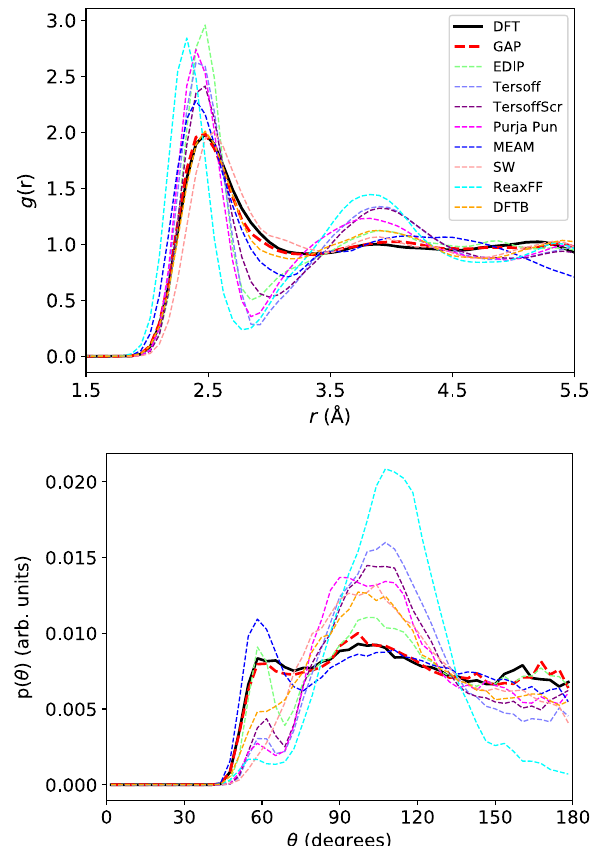
FIG. 7. Liquid silicon radial and angular structure from well- equilibrated constant temperature and pressure 64-atom samples at P ¼ 0 GPa and T ¼ 2000 K. Top: RDF. Bottom: ADF. The black solid line indicates DFT results, the red dashed line and symbols indicate GAP results, and dashed lines (various colors) indicate the DFTB and other interatomic potentials.